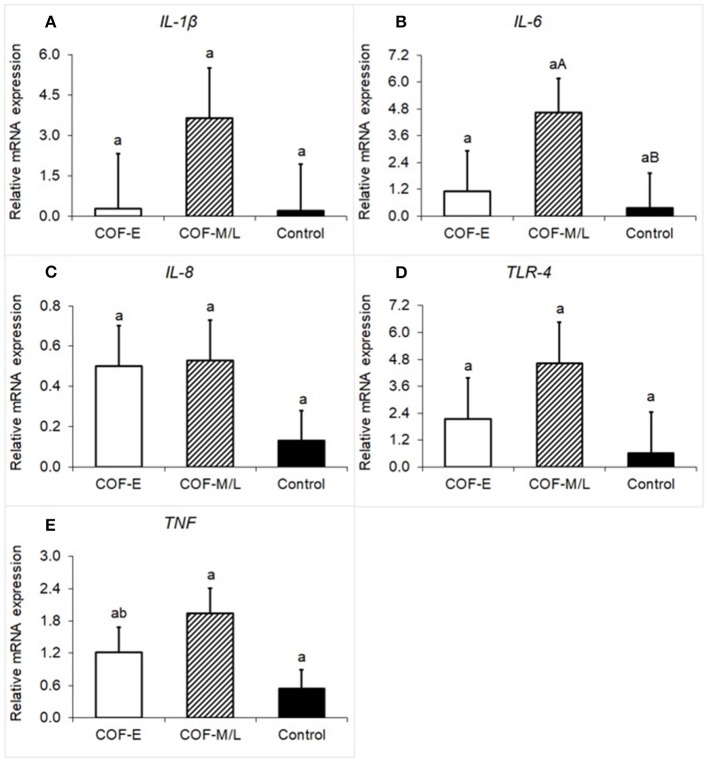
Fold-change in mRNA expression for five pro-inflammatory genes (A)
IL-1β, (B)
IL-6, (C)
IL-8
(D), TLR-4, and (E)
TNF detected in the follicular fluid in cows diagnosed with COF at early (COF-E) and mid-late (COF-M/L) lactation and the control cows. Different letters (a,b) represent different (P < 0.05) least-square means and capital letter (A,B) represent tendencies (0.05 < P ≤ 0.10). Error bars represent the mean standard error.